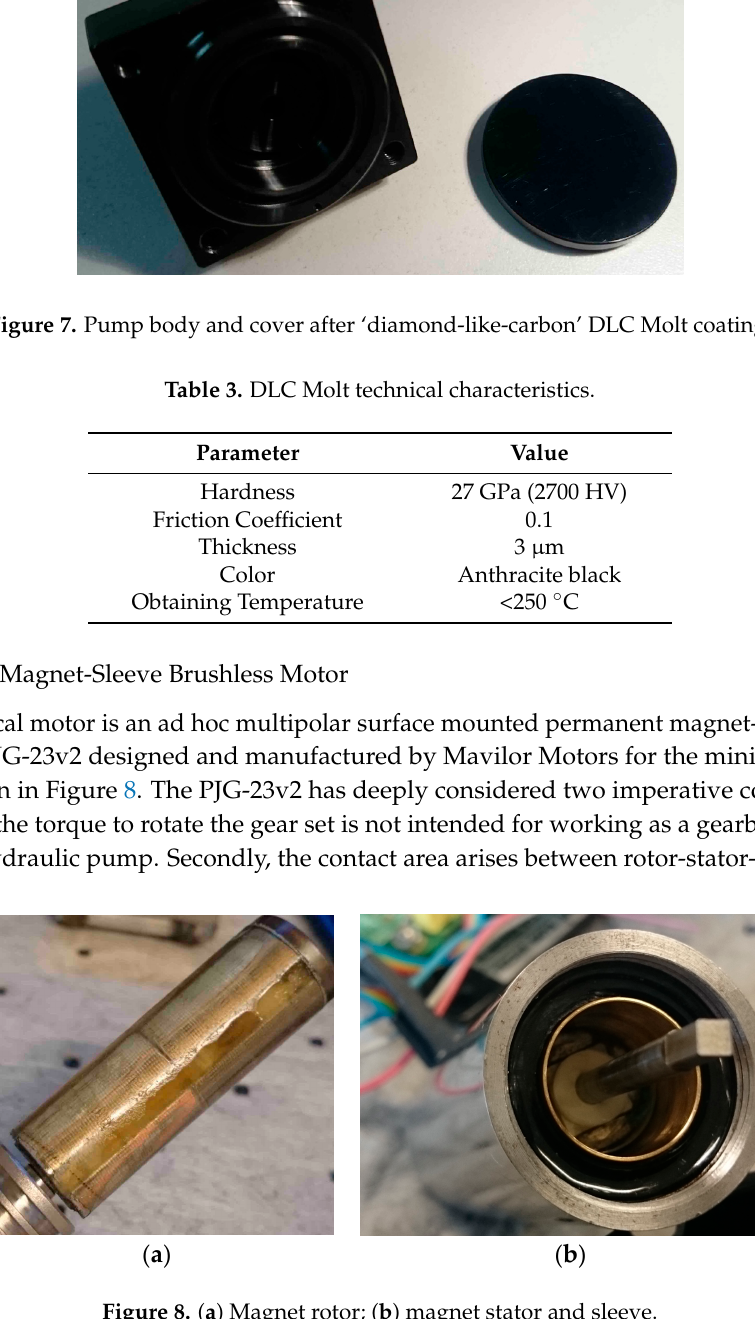
Table 4. PJG-23v2 motor data of mTGp.